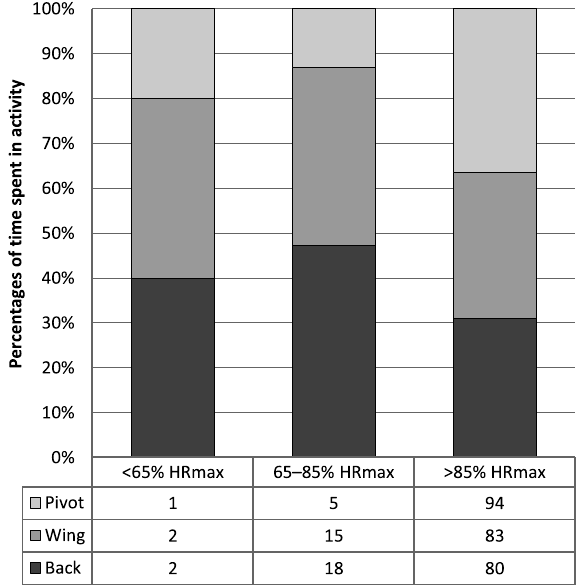
Figure 1. Percentages of time spent in low activity (< 65% HR ), moderate activity (65–85% HR ) and max max very vigorous activity (> 85% HR ) in players by play- max ing positions during the competitive